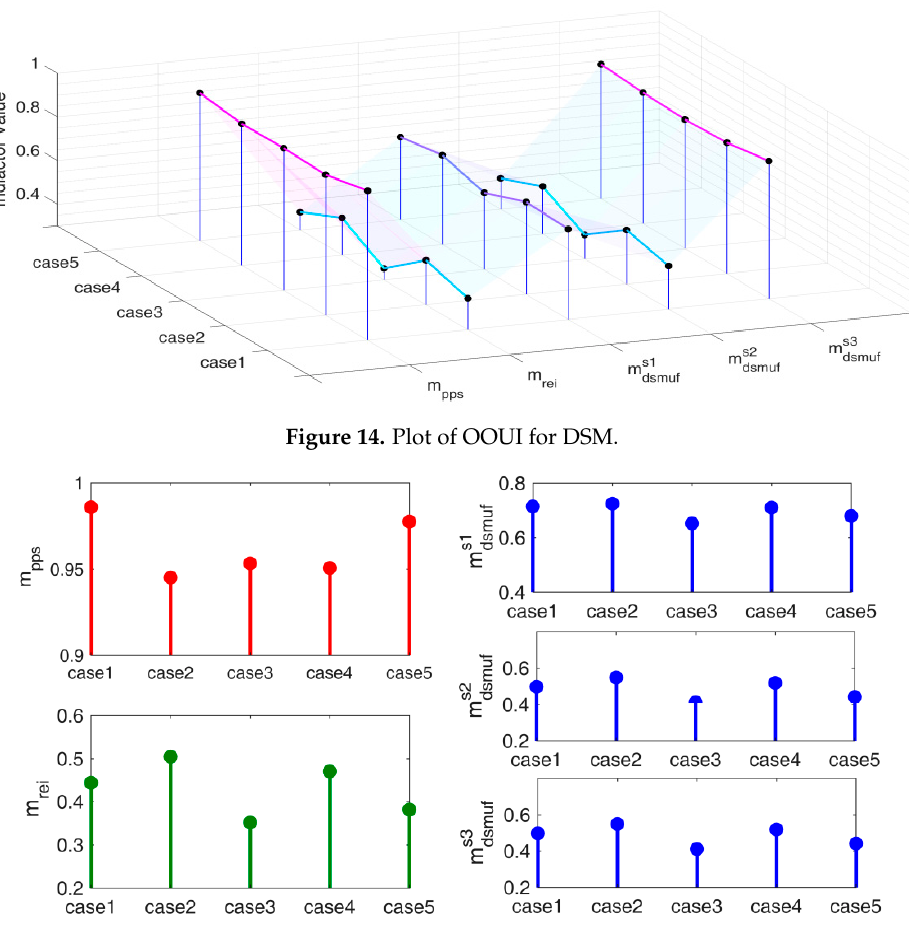
Figure 15. Plot of OOUI for DSM in different cases and scenarios as described in Table 4.